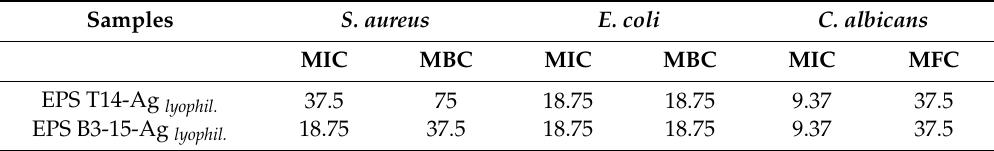
Table 3. Antimicrobial activity of lyophilized EPS T14-Ag NPs and EPS B3-15-Ag NPs ( µ g / mL).